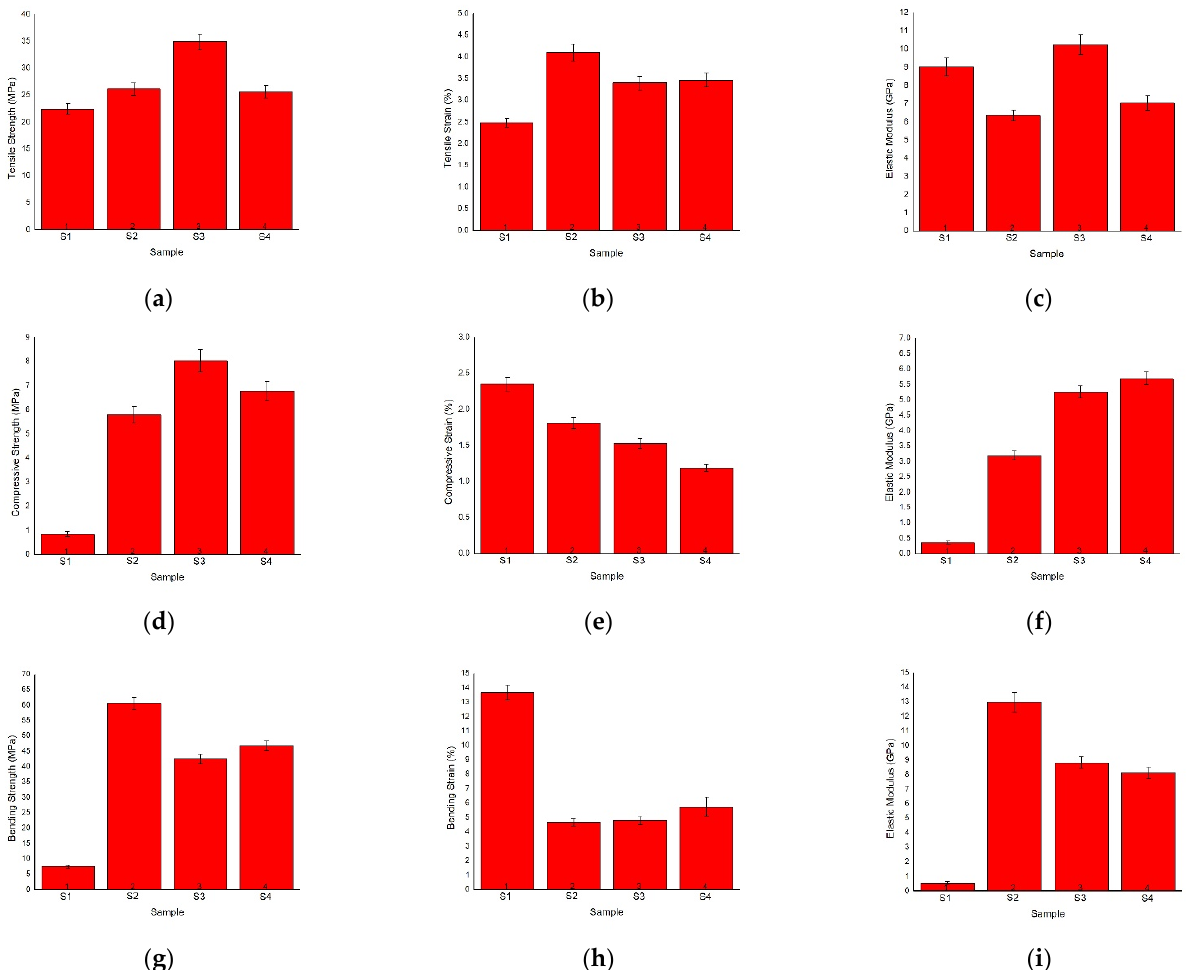
Figure 3. ( a − d ) Tensile strength graph of JCJC spent tea leaf composites: ( a ) S1, ( b ) S2, ( c ) S3, and ( d ) S4; ( e − h ) compression strength graph of JCJC spent tea leaf composites: ( e ) S1, ( f ) S2, ( g ) S3, and ( h )